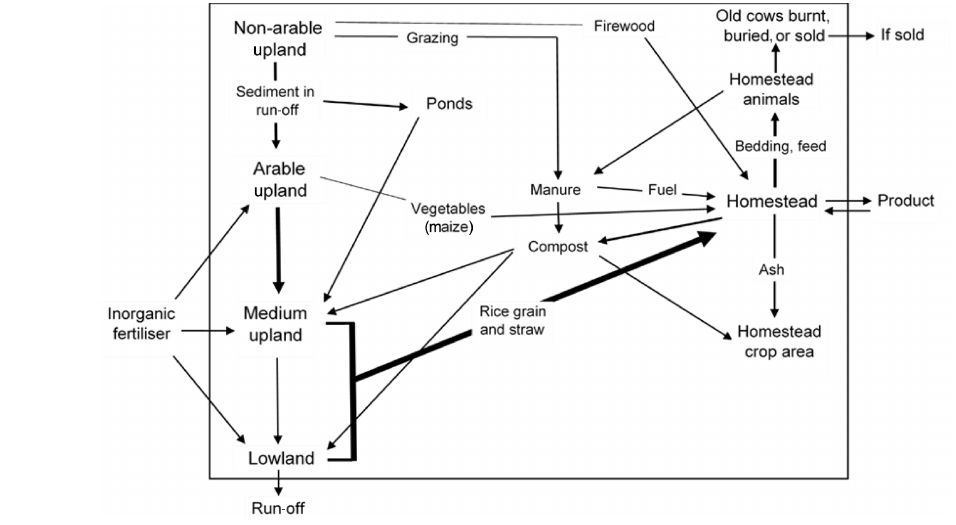
Figure 7. Indicative nutrient flows. Line weight reflects relative magnitude (see text for